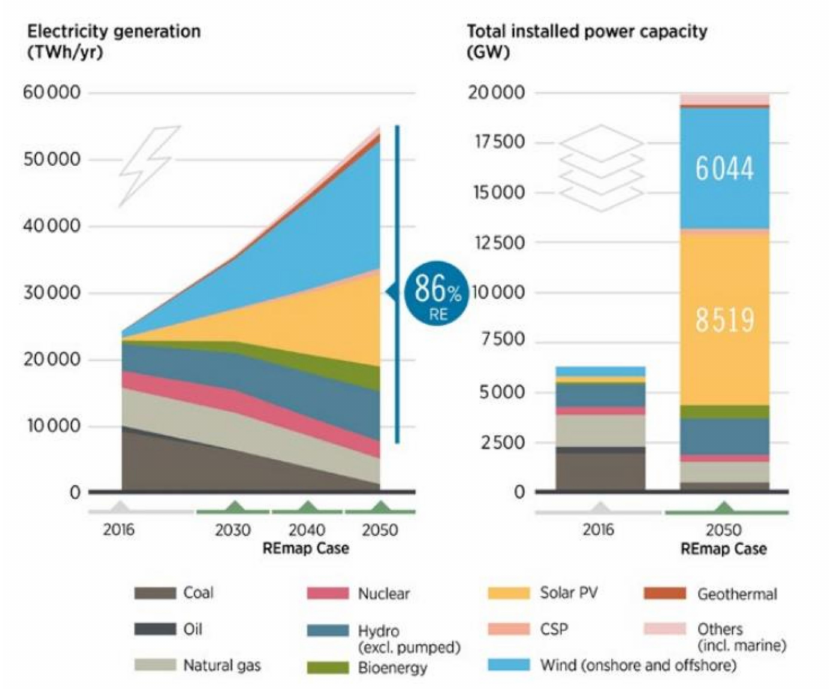
Figure 3. Share of different energy technologies in electricity generation and capacity